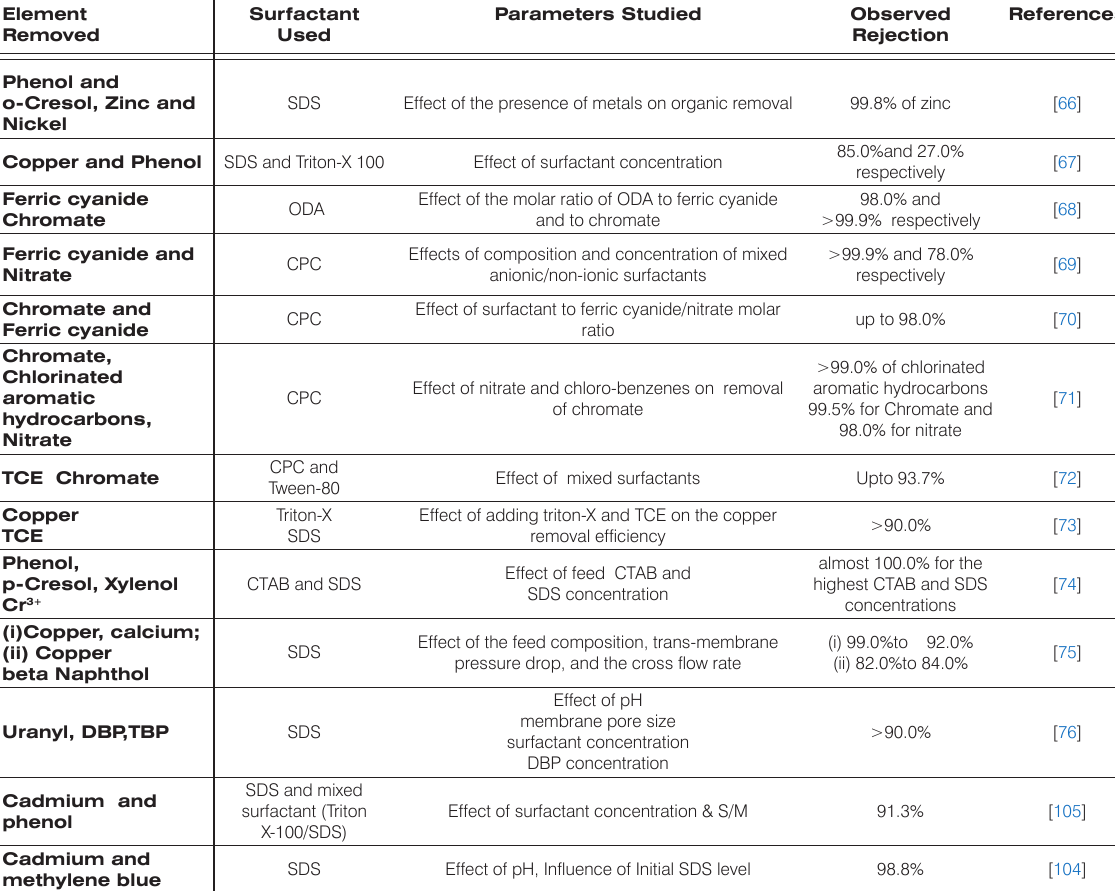
Table 4. Removal of combination of organics and metal by MEUF